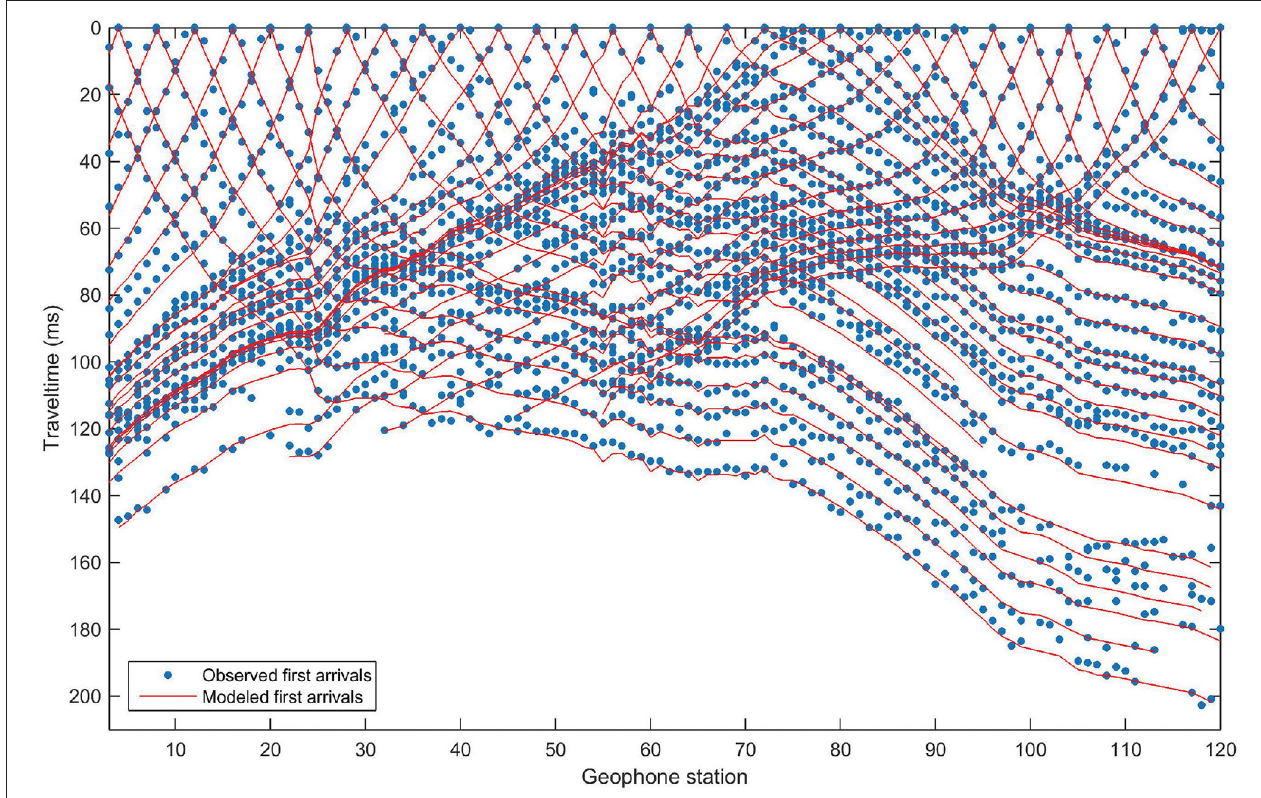
FIGURE 6 | Observed and modeled first arrival travel times for Line 4. Generally the observed and modeled travel times from the final model are in good agreement; however, at the far and near offset receivers the fit is worse as the first arrivals are more difficult to pick.